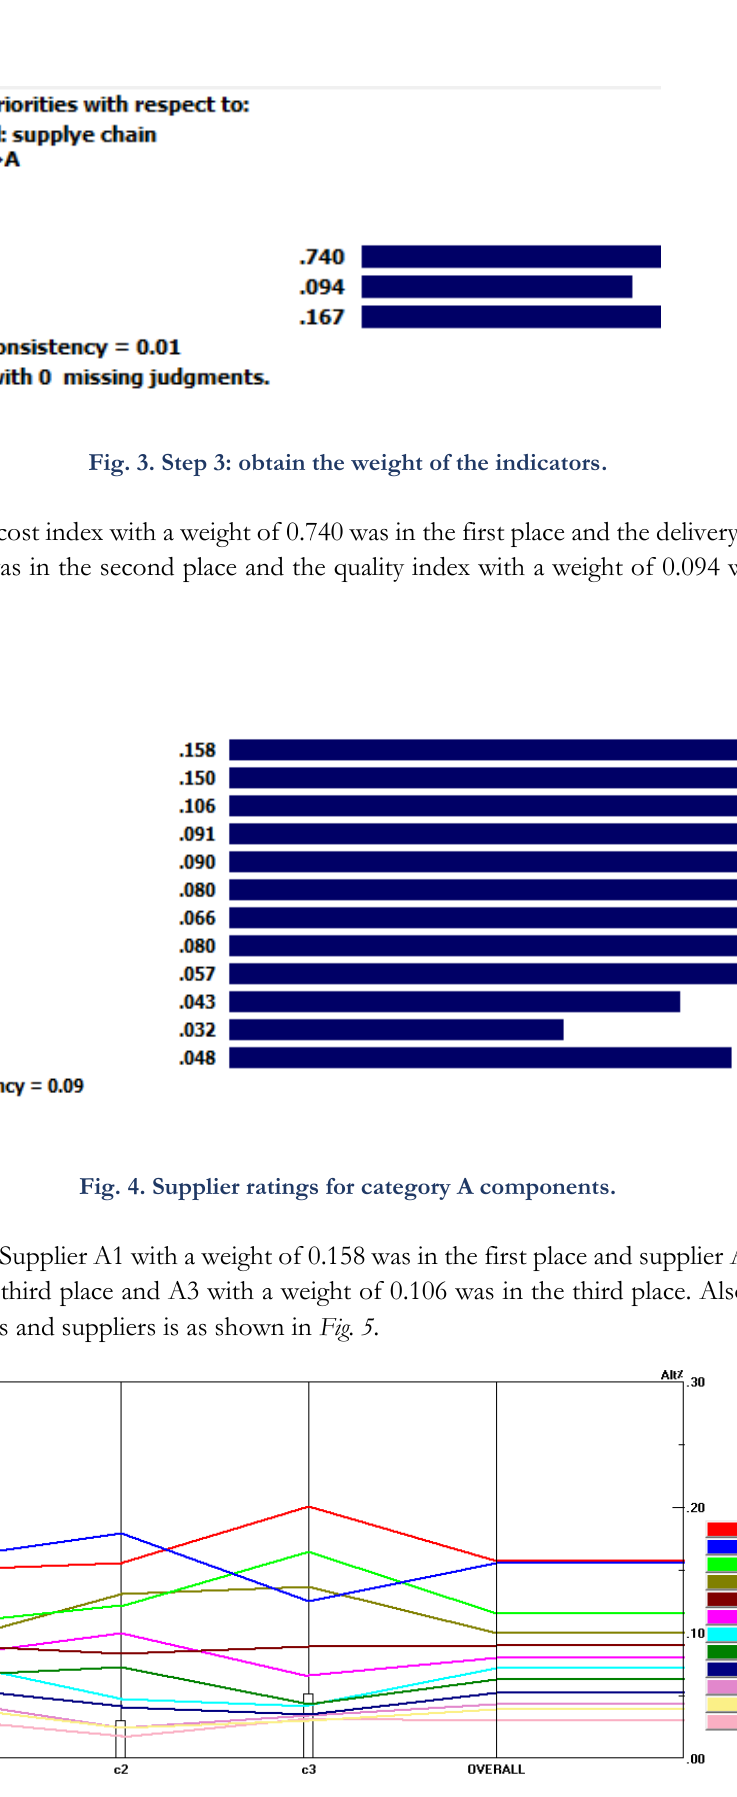
Fig. 5. The sensitivity analysis of indicators and suppliers for category